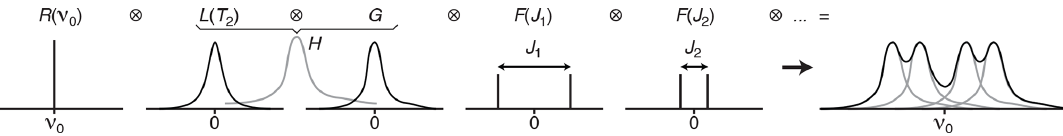
Figure 1. Multiplet structure of a 1D NMR spectrum expressed as the convolution product of the contributions of the Larmor frequency of the nucleus R ( υ 0 ), the Lorentzian line shape L ( T 2 ), the B 0 -field inhomogeneity G (inhom.) and the scalar coupling constants F ( J i ).